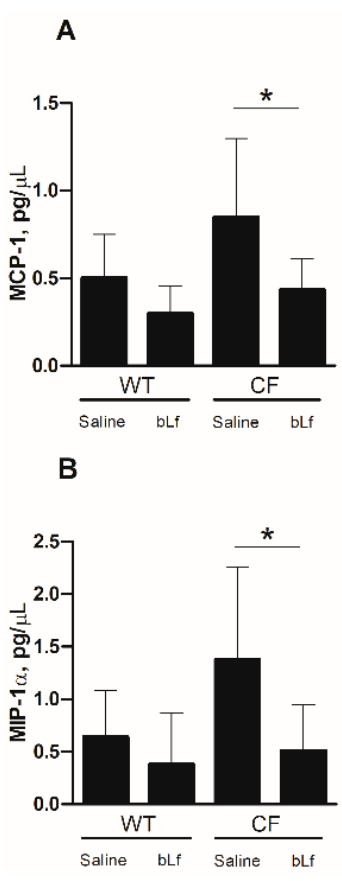
Figure 4. Changes in Monocyte Chemoattractant Protein (MCP)-1 and Macrophage Inflammatory Protein (MIP)-1 α levels in lung homogenates of WT and CF mice after 7 treatments with aerosol administration of 50 µ L sterile saline or 200 µ g / 50 µ L bLf. Error bars: standard error of the mean. Statistical significance is indicated as follows: *: p < 0.05 (Mann-Whitney U test) . Table 1. Cytokines/chemokines levels in infected wild-type (WT) and cystic fibrosis (CF) mice treated or not treated with bovine lactoferrin (bLf).